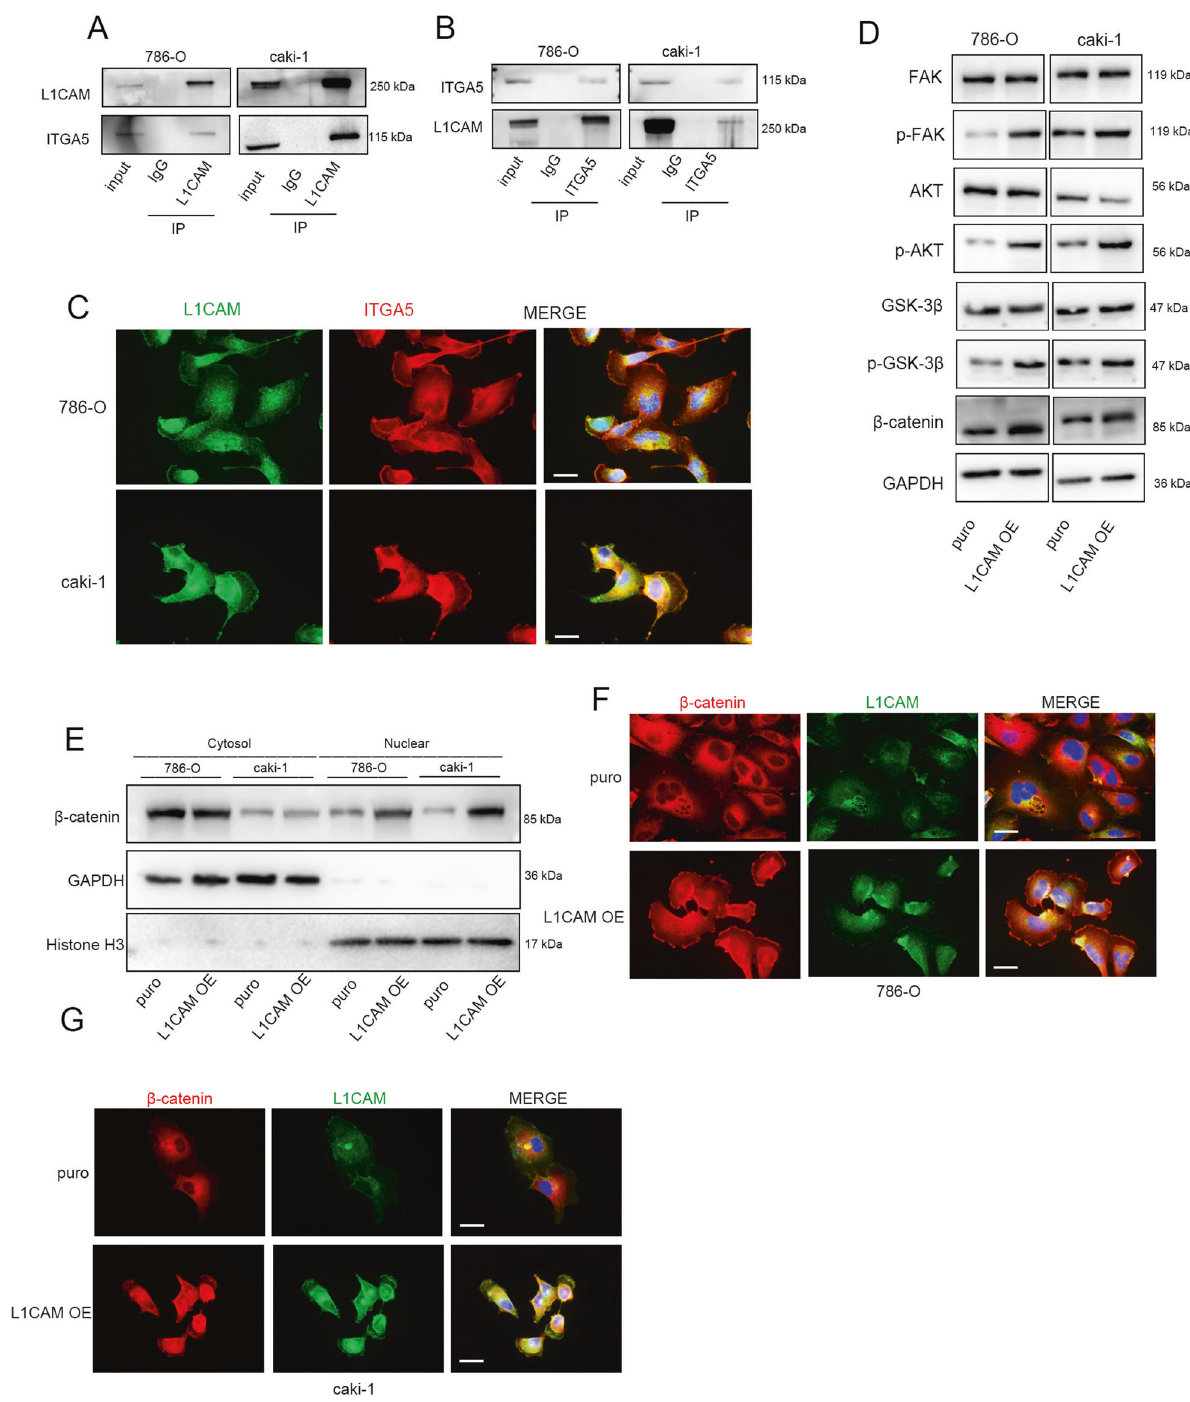
Fig. 6 L1CAM interacts with ITGA5 and elicits activation of signaling downstream of integrin α 5 β 1. A , B IP followed by western blotting. C Double staining with L1CAM and ITGA5 (confocal microscopy; 400× magni fi cation). D Activation of protein kinases in integrin α 5 β 1 signaling. E β -catenin expression in the cytoplasm and nucleus following L1CAM overexpression. F , G Immuno fl uorescence staining of β -catenin in L1CAM overexpressing RCC cells (400× magni fi cation). HUVECs for 24 h in conditioned media, followed by RNA-sequencing (RNA- seq) transcriptome analysis (Beijing Novogene Corporation). RNA-Seq libraries were generated using the NEB Next Ultra Directional RNA Library data were normalized, and clean reads were obtained from the raw data by Prep Kit from Illumina (San Diego, CA, USA) according to the excluding adapters, poly-N sequences, and low-quality reads to obtain manufacturer ’ s protocol. The effect of soluble L1CAM on vascular high-quality cleaning data. Statistical analysis was performed for false